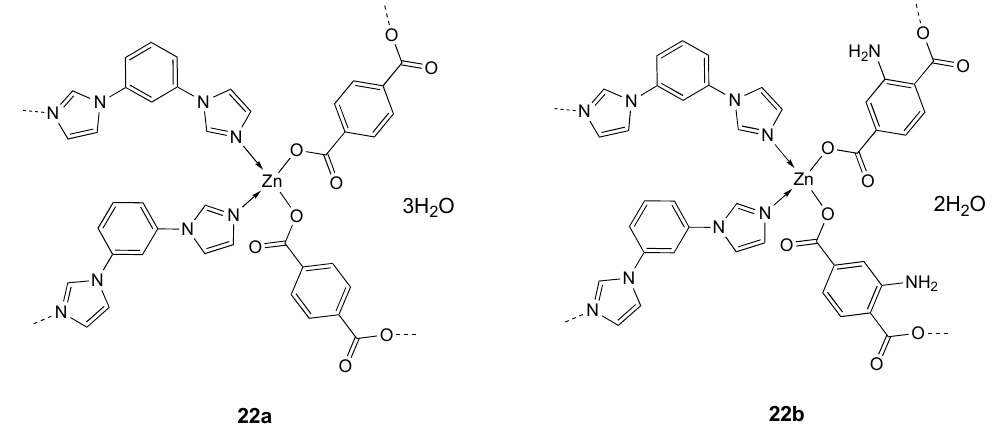
Figure 12. Structure of the zinc complexes 22a , 22b .